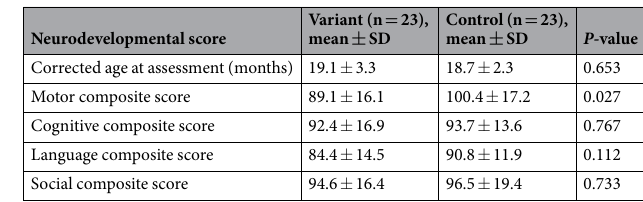
Table 4. Neurodevelopmental scores of Bayle III in preterm infants according to the g.-273G > A variation at 18–22 months of corrected